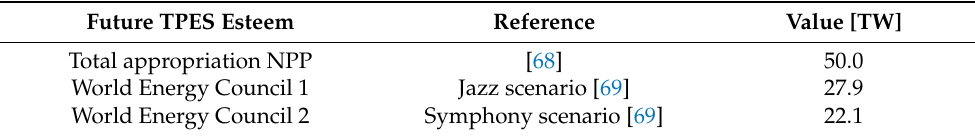
Table 7. Foreseen Total Primary Energy Supply (TPES) values, expressed in units of [TW]; potential reduction scenarios (data derived from